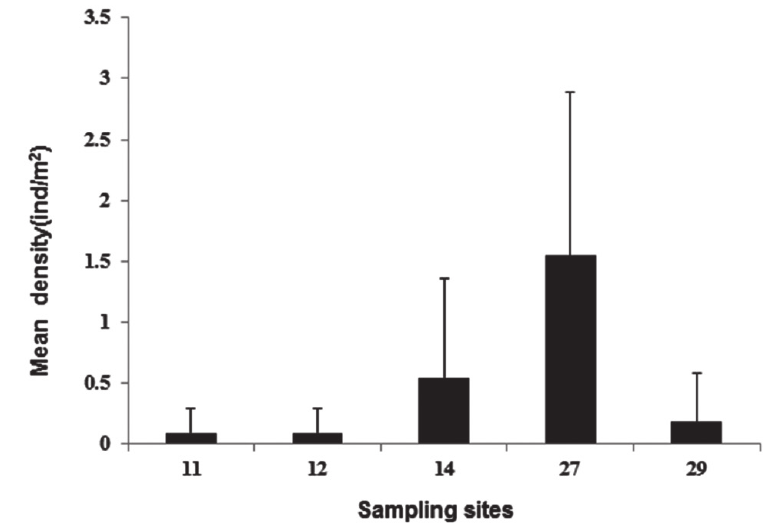
Figure 4. The mean density of S. carinata along the 5 sites with mussels in the Ganjiang